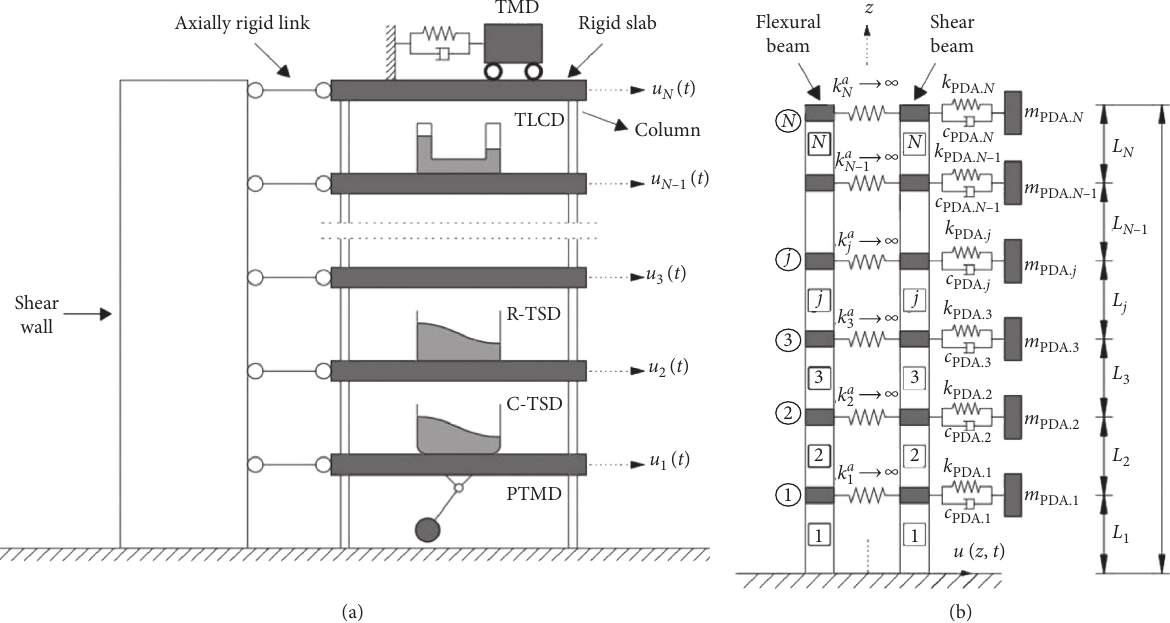
Figure 2: Coupled shear-flexural model for an N -story building with PDAs. (a) Sketch. (b) Equivalent discrete model [37].